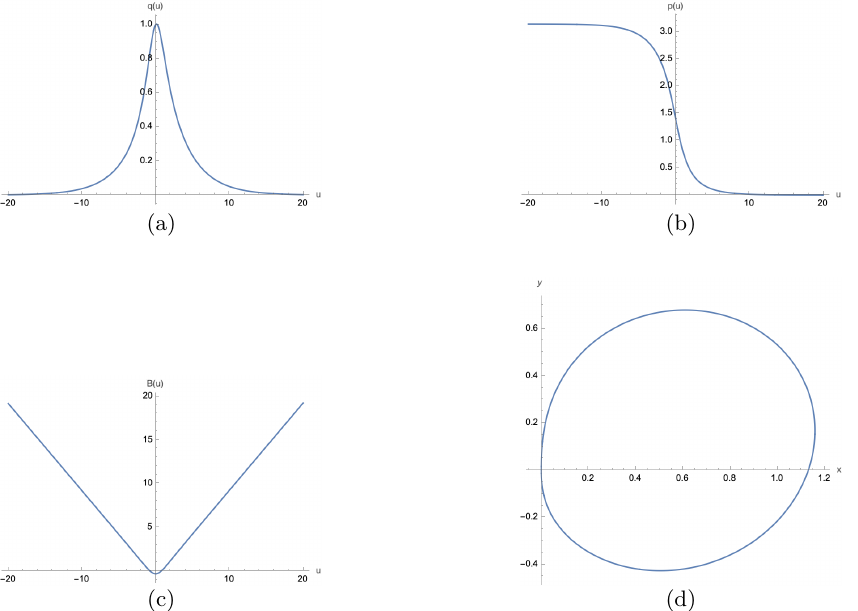
Figure 3. (a)-(c) plots of q, p, B respectively, (d) parametric plot of the Janus flow in the x, y variables. The initial conditions are q (0) = 1 . 0 and p (0) = 1 . 5 and α = 2 . 3